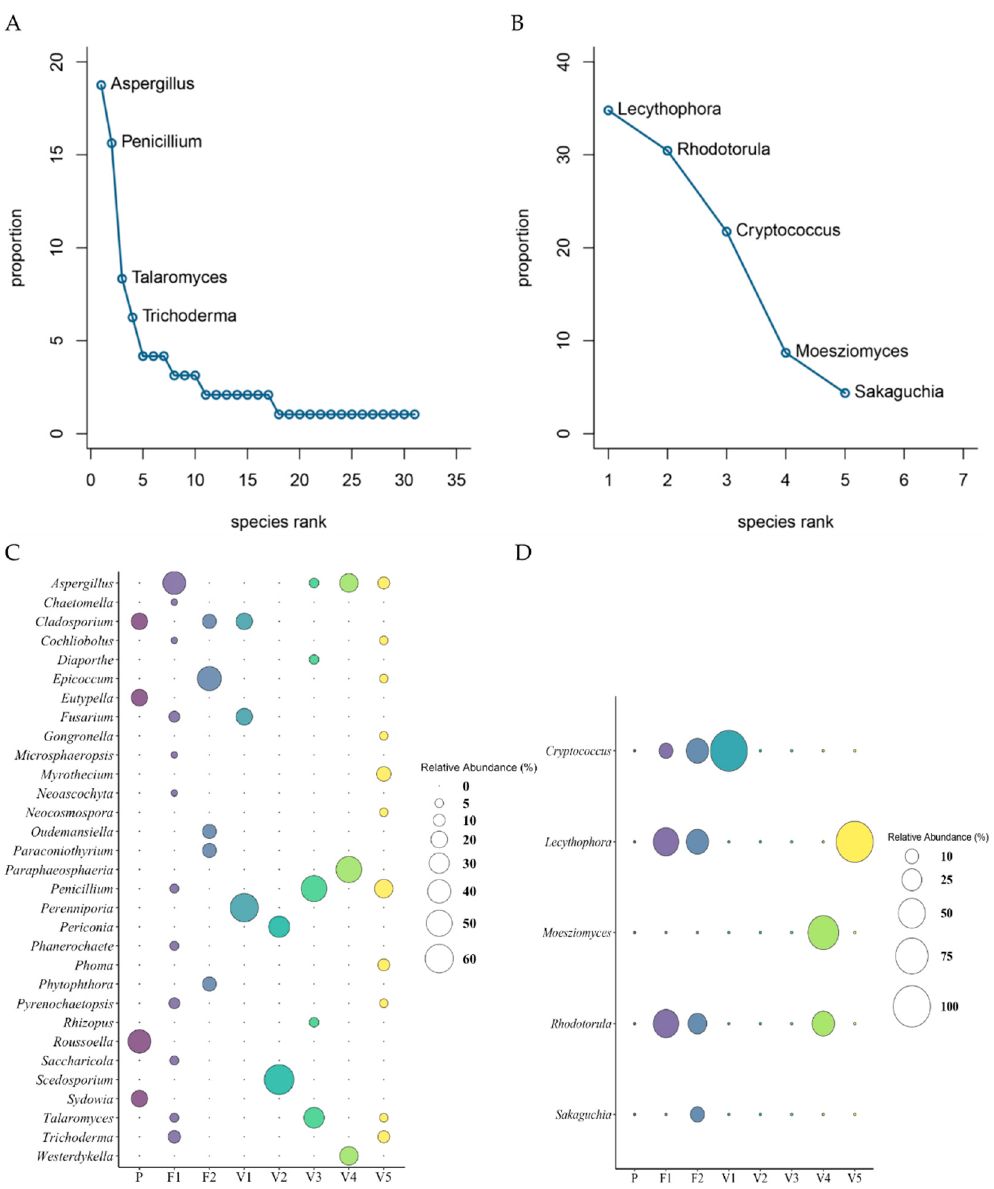
Figure 7. Rank abundance curves of ( A ) filamentous fungi and ( B ) yeast genus distributions are illustrated. The y -axis shows the proportional abundance (species abundance/total abundance) for a given genus, and the rank of genera from highest to lowest are represented on the x -axis. In the case of ( A ), several genera are dominant and appear written on the graph, while the long tail represents several rare genera in the fungal community. In the case of ( B ), the graph has no tail and, thus, shows that only a couple genera are rare. Based on the slopes observed, the filamentous fungal curve, which is steep, indicates lower evenness (i.e., a less homogeneous community is in terms of the abundances of genera present) than the yeast curve, which is less steep. The relative abundance of ( C ) filamentous fungi and ( D ) yeast genera is illustrated. In ( C ), 31 filamentous fungal genera were detected among all the sites; ( D ) 5 yeast genera were observed in 5 of the 8 sites. The yeast recovered belonged to 2 phyla, Basidiomycota (65.23%) and Ascomycota (34.78%). At the class level, 6 taxa were identified. Sordariomycetes, Microbotryomycetes, Tremellomycetes, Ustilaginomycetes, Agaricomycetes, and Cystobasidiomycetes were detected (34.78%, 30.44%, 17.39%, 8.70%, 4.35%, and 4.35%, respectively). A total of 5 genera of yeast were identified. Lecythophora 34.78% (8 individuals), Rhodotorula 30.43% (7 individuals), and Cryptococcus 21.74% (5 individuals) were the more dominant genera detected. Moesziomyces and Sakaguchia accounted for 8.7% (2 individuals) and